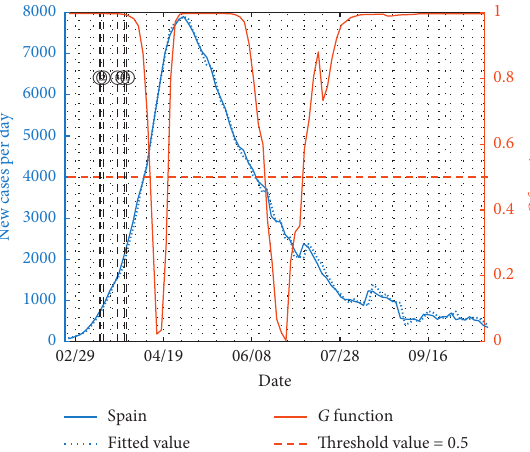
Figure 7: The fitting result of France. The left axis shows the daily confirmed cases for the real data after smoothness (blue solid line) and its fitted values by the STAR model (blue dashed line). The right axis shows the value of nonlinear functions G changing with time (orange solid line) and the reference line with threshold 0.5 (orange dashed line). The vertical dotted line indicates the se- quential released policies: ① close all nonessential areas, ② declare the highest stage of epidemic prevention and close all nonessential public places, ③ close all schools, ④ close borders, and ⑤ put field hospitals into operation.